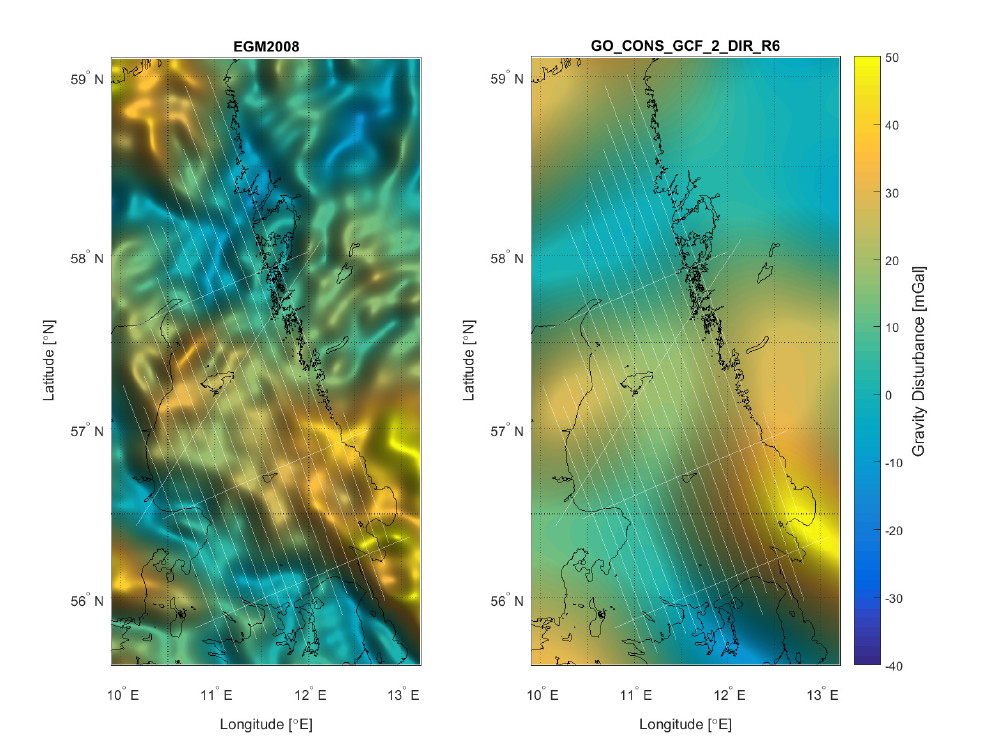
Figure A1. Gravity disturbance computed from two global geopotential models at 1 km altitude. (Left): EGM2008; (Right): GO_CONS_GCF_2_DIR_R6.